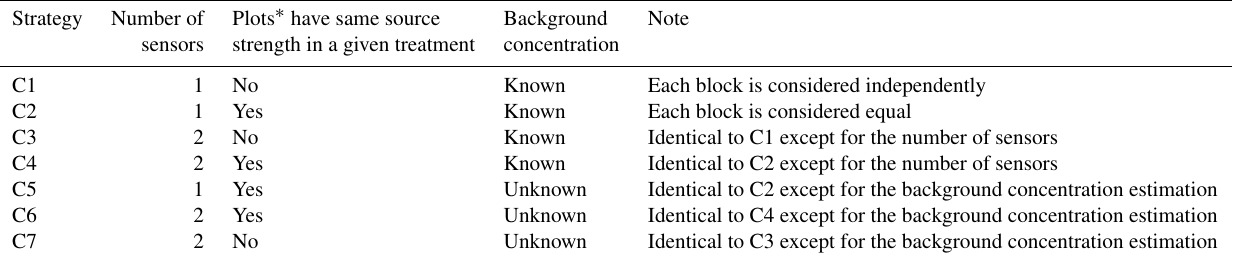
Table 1. Scenarios tested for inferring the sources and background concentration. Strategy Number of Plots ∗ have same source Background Note sensors strength in a given treatment concentration